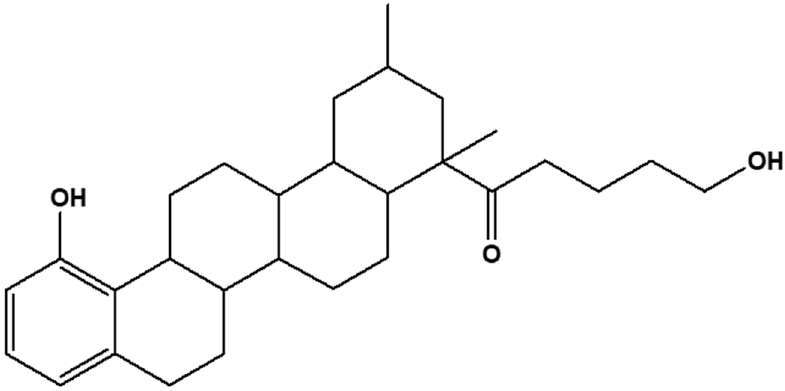
Figure 2. Structure of E1 (10 ‐ hydroxy ‐ 1,3 ‐ dimethylchrysen ‐ 3 ‐ yl) ‐ 5 ‐ hydroxypentan ‐ 1 ‐ one).